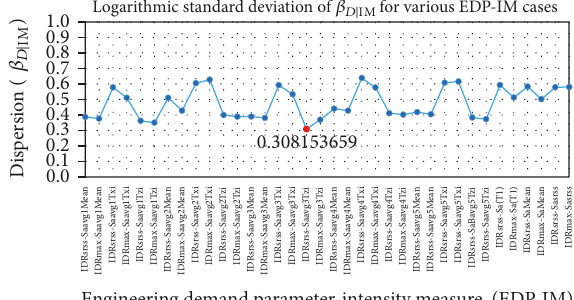
Figure 6: Dispersion values for various EPD-IM scenarios in 12- story building with fixed